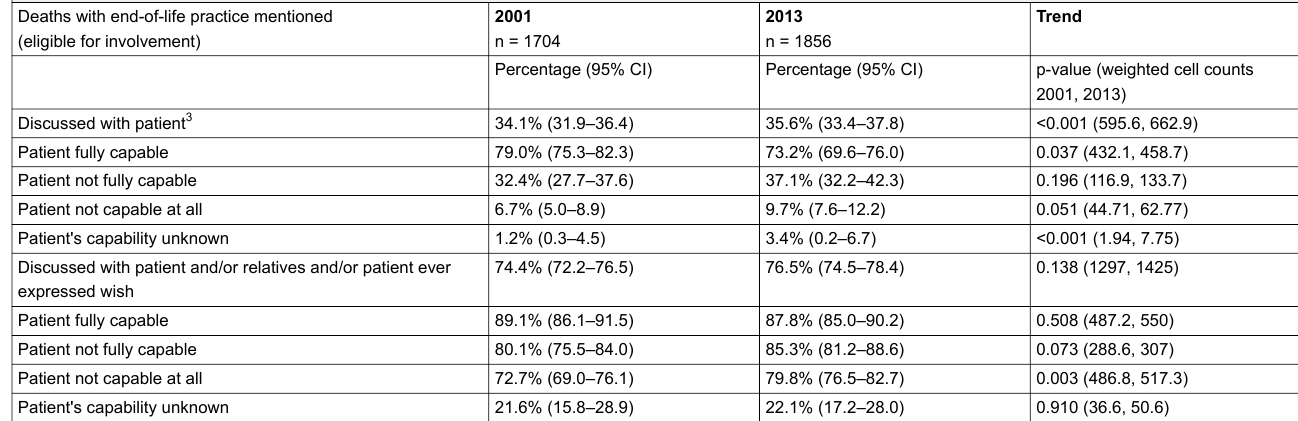
Table 4: Discussion of medical end-of-life decisions in function of the patient's decision-making capacity, German-speaking part of Switzerland 2001 vs 2013. (100% = all deaths with reported end-of-life practice; percentages weighted and standardized to 2013 deaths). Deaths with end-of-life practice mentioned (eligible for involvement)